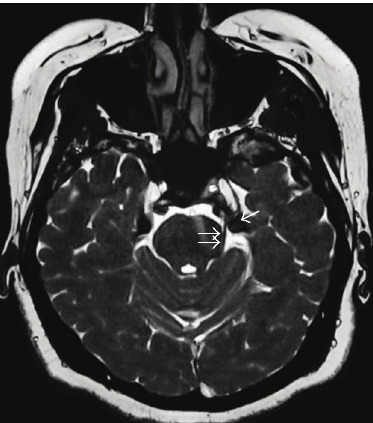
Figure 1: Axial 3D FIESTA MR image shows nodular lesions (arrow) with dark signal intensity adjacent to the porus trigeminus bilaterally. The cisternal segment of the left trigeminal nerve (double arrows) is impinged by nodular lesions.